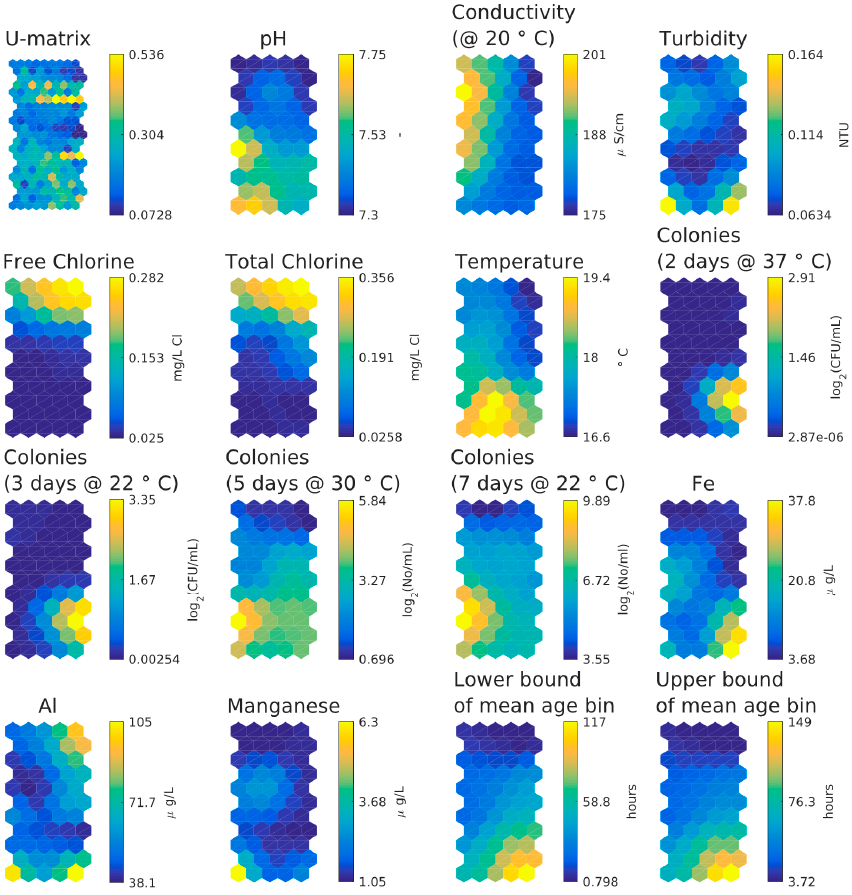
Figure 8. SOM component planes for the customer taps dataset.